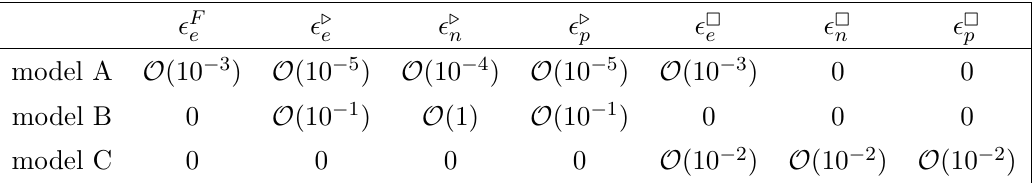
Table 2 . Reachable magnitude of the Fierz and loop-induced NSI in the three models under study. Here (cid:15) F , (cid:15) . and (cid:15) are generated by Fierz transformations, triangle and box diagrams respectively. (cid:31) (cid:30)(cid:23) (cid:23) . Since right-handed neutrinos do not couple to the Z boson there is no triangle (cid:11)L (cid:12)R NSI in this model,